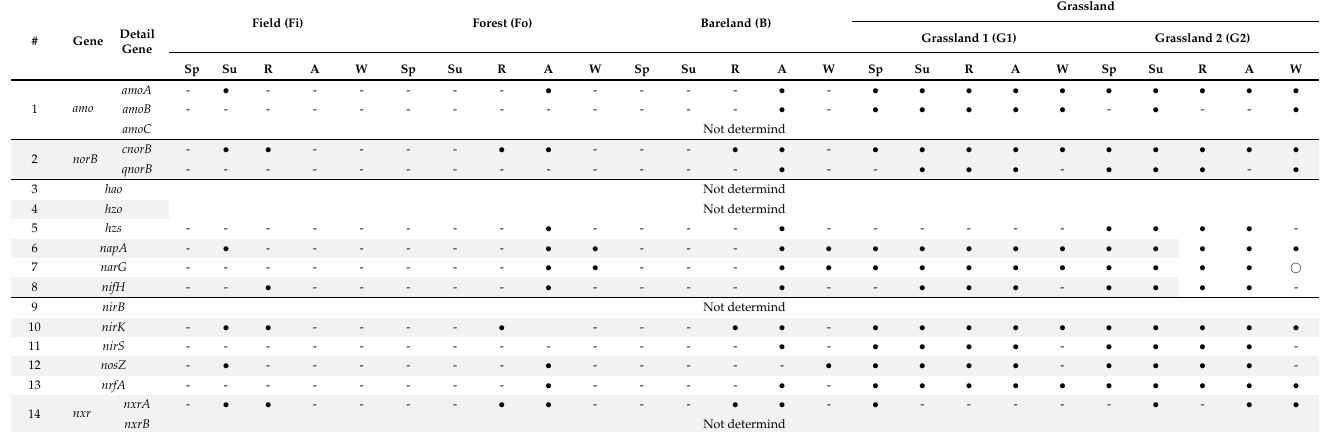
Table 3. Surface soil monitoring results according to land use type and season. Sp, spring; Su, summer; R, rainy season in summer; A, autumn; W, winter; • , positive; -,